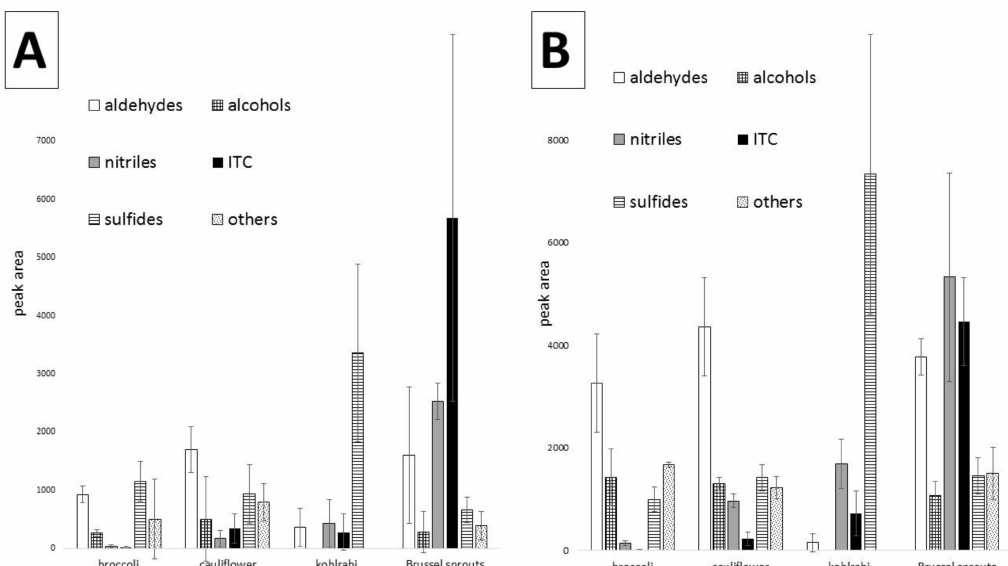
Figure 4. Mean values in different cultivars of analyzed raw ( A ) and cooked ( B ) vegetables. For broccoli, it is the mean value from three cultivars: Covina, Malibu and “2970”, for cauliflower, from three cultivars: Charlotte, Oviedo, Liria, for kohlrabi, from four cultivars: Kolibri, Konan, Konmar, Kordial and for Brussels sprouts, from five cultivars: Ajax, Marte, Maximus, Neptuno, Profitus. The results are the mean of three replicates for each cultivar (i.e., nine analyses for broccoli and cauliflower, 15 for Brussels sprouts and 12 for kohlrabi), error bars show standard deviation. Amounts were expressed in total (sum of) peak